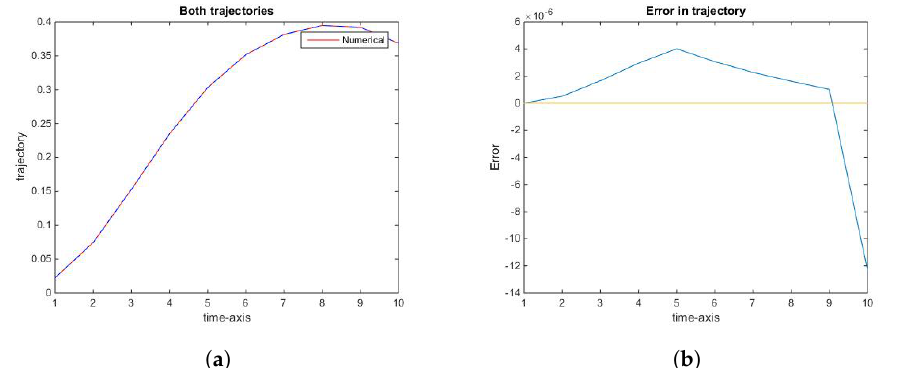
Figure 2. Accuracy of the optimal state trajectory. ( a ): The trajectories of numerical (red) and actual (blue dashed) state variable, X ( t ) , for the social optimum; ( b ): The error in the trajectory of the state variable, X ( t ) , for the social optimum.